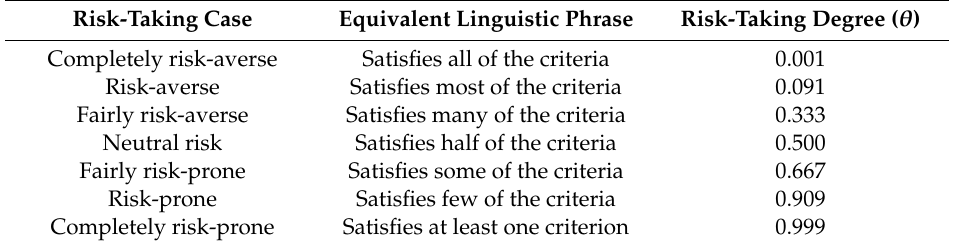
Table 2. Risk-taking cases, equivalent linguistic phrases, and relevant risk-taking degrees